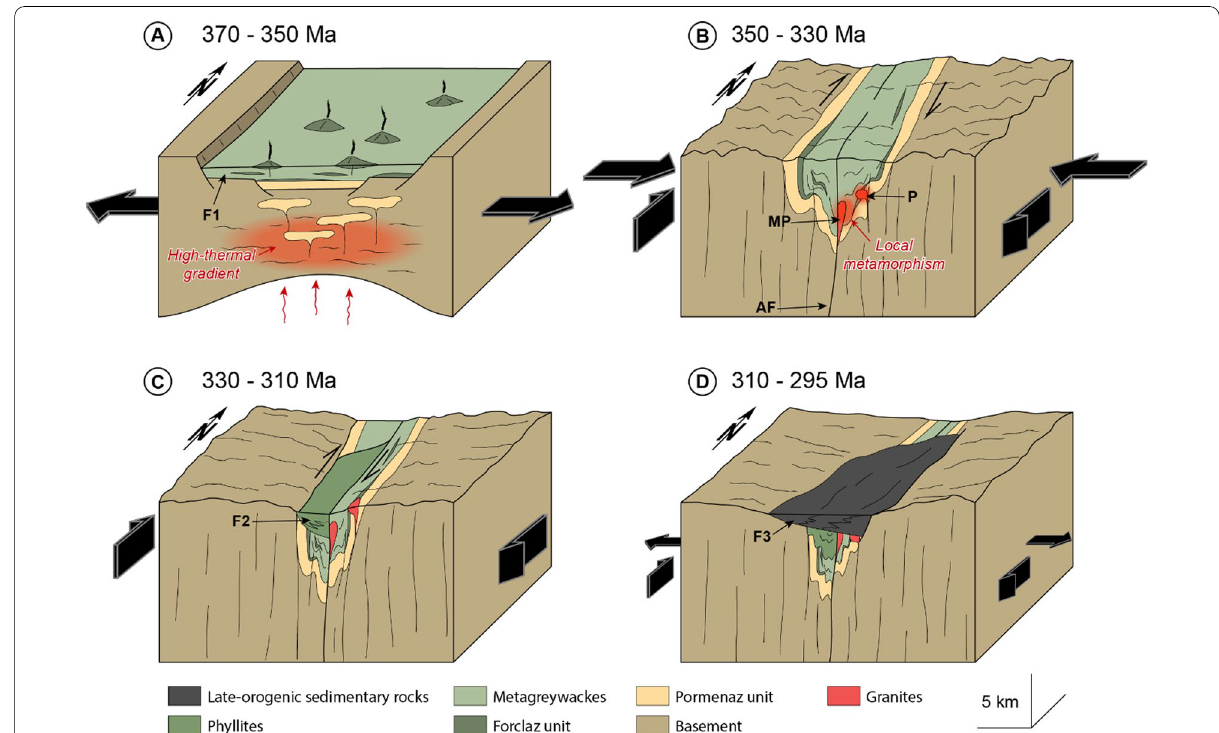
Fig. 10 Geodynamic evolution of the Servoz basin. A 370–350 Ma: Back‑arc rifting induced a crustal thinning and a high heat mantle flux leading to the partial melting of the crust, the formation of a bimodal magmatism, and a high‑thermal gradient in the metagreywackes forming the F1. B 350–330 Ma: Transpression during the continental collision inverted the basin and drained melts from the lower crust forming the Pormenaz (P) and Montées‑Pélissier (MP) granites which induced contact metamorphism. C 330–310: The crustal dextral deformation formed a pull‑apart basin in the western side of the Arve fault (AF) allowing the sedimentation of the F2 phyllites while the eastern side was exhumed. D 310–295 Ma: late‑orogenic extension in a transtensional setting forming the late basins and the